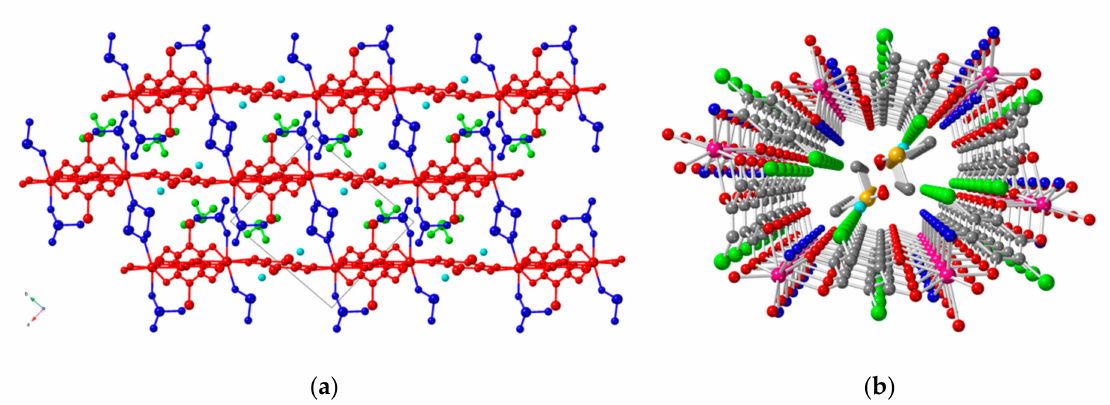
Figure 6. ( a ) Side view of three consecutive layers in 2 (in red) showing the coordinated dmso molecules (dark blue), the crystallization dmso molecules (green) and the crystallization water molecules (ligh blue); ( b ) Perspective view of one hexagonal channel in 2 along the b direction showing the crystallization dmso and water molecules located in the channels. Colour code in b : Dy = pink, C = grey, S = yellow, Cl = green, O anilato = red, O water = light blue, O dmso = dark blue. H atoms have been omitted for